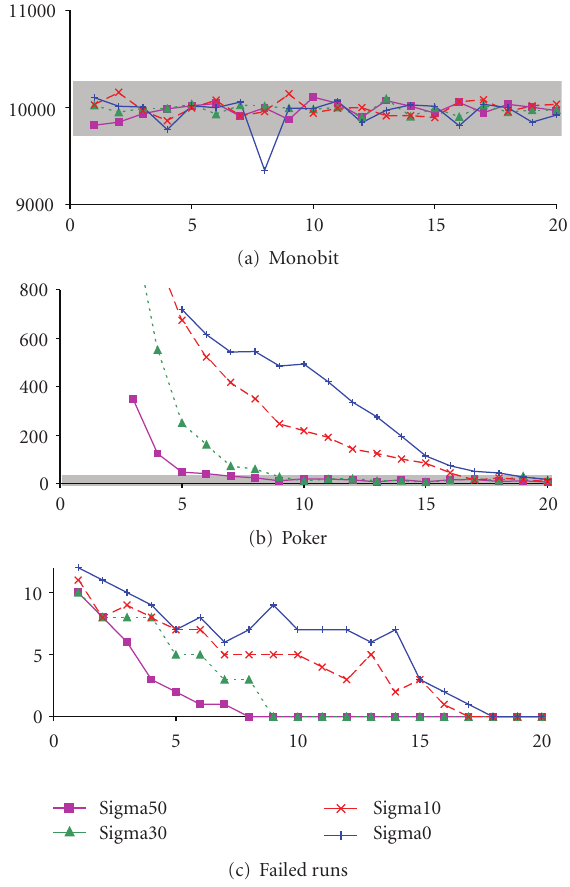
Figure 7: Results of the FIPS 140-2 tests in the Wold’s TRNG architecture simulations with varying size of injected Gaussian